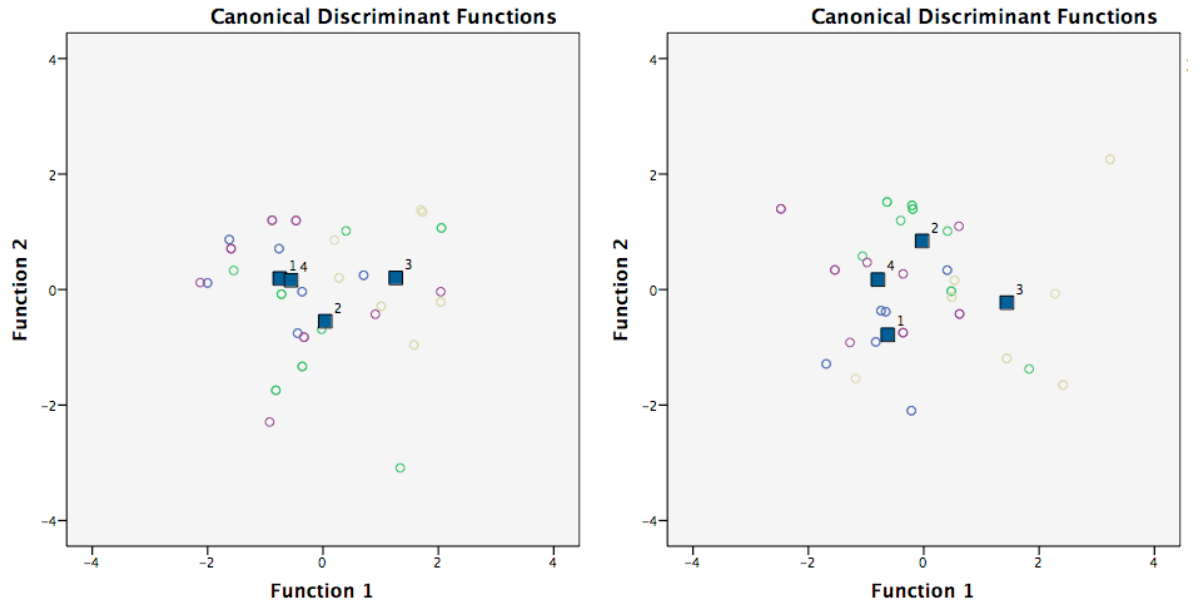
Fig. 2. Dynamics of test results in boys aged 8. CTE6: 1 – load variant І, 2 – load variant ІІ, 3 – load variant ІІI, 4 – load variant ІV